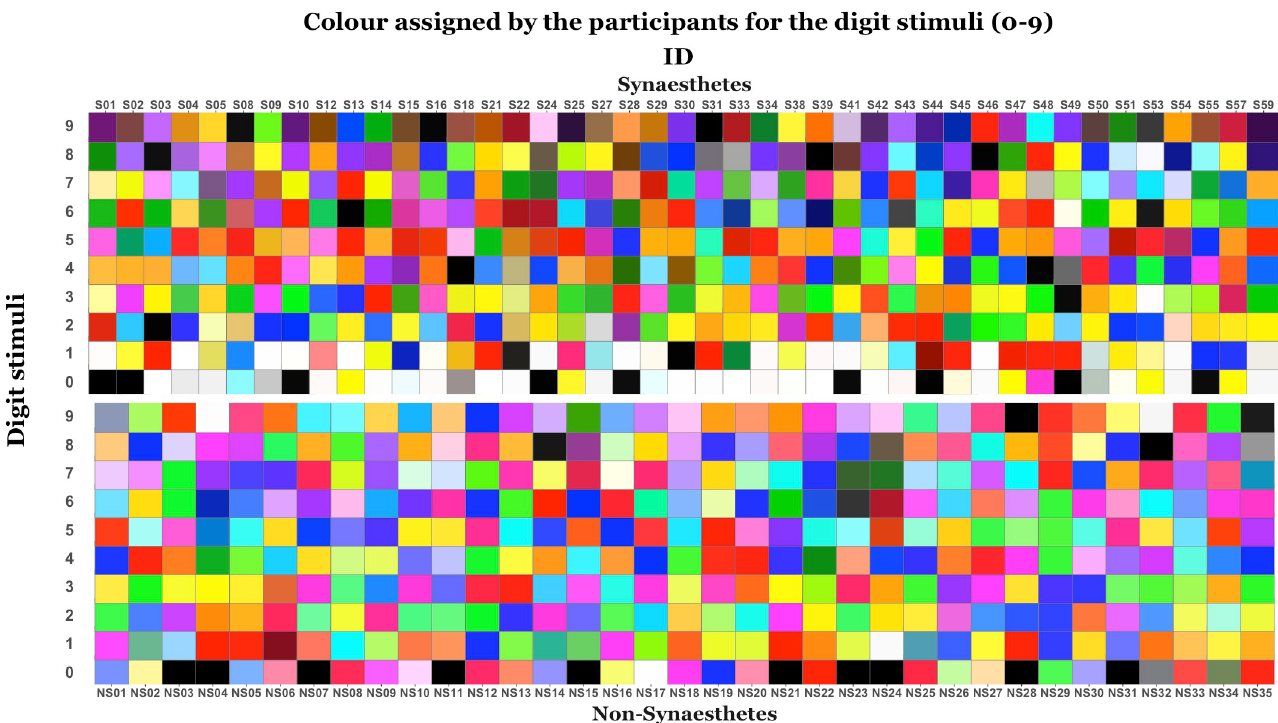
Fig 3. Colour swatches demonstrating the different colours assigned by each participant for the digits of their congruent condition: Synaesthetes (n = 43) | non-synaesthetes (n = 35).